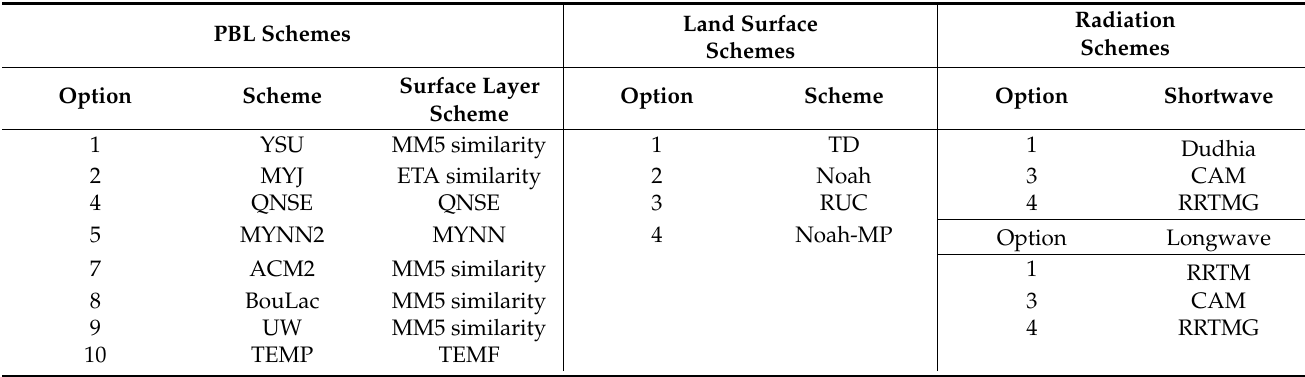
Table 2. Physical parameterization schemes of the WRF model used for the optimization with the option numbers the same as in the WRF namelist. The non-local closure schemes are YSU, ACM2, and TEMF scheme. The local closure schemes are MYJ, QNSE, MYNN2, BouLac, and UW